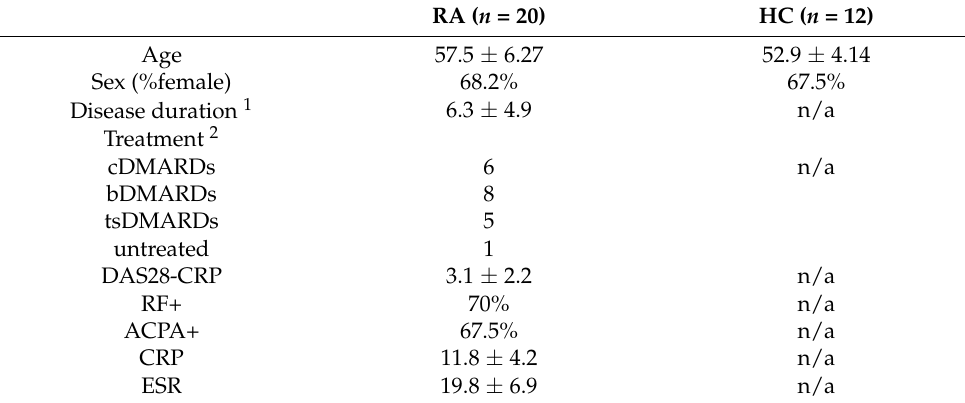
Table 1. Patients’ characteristics.